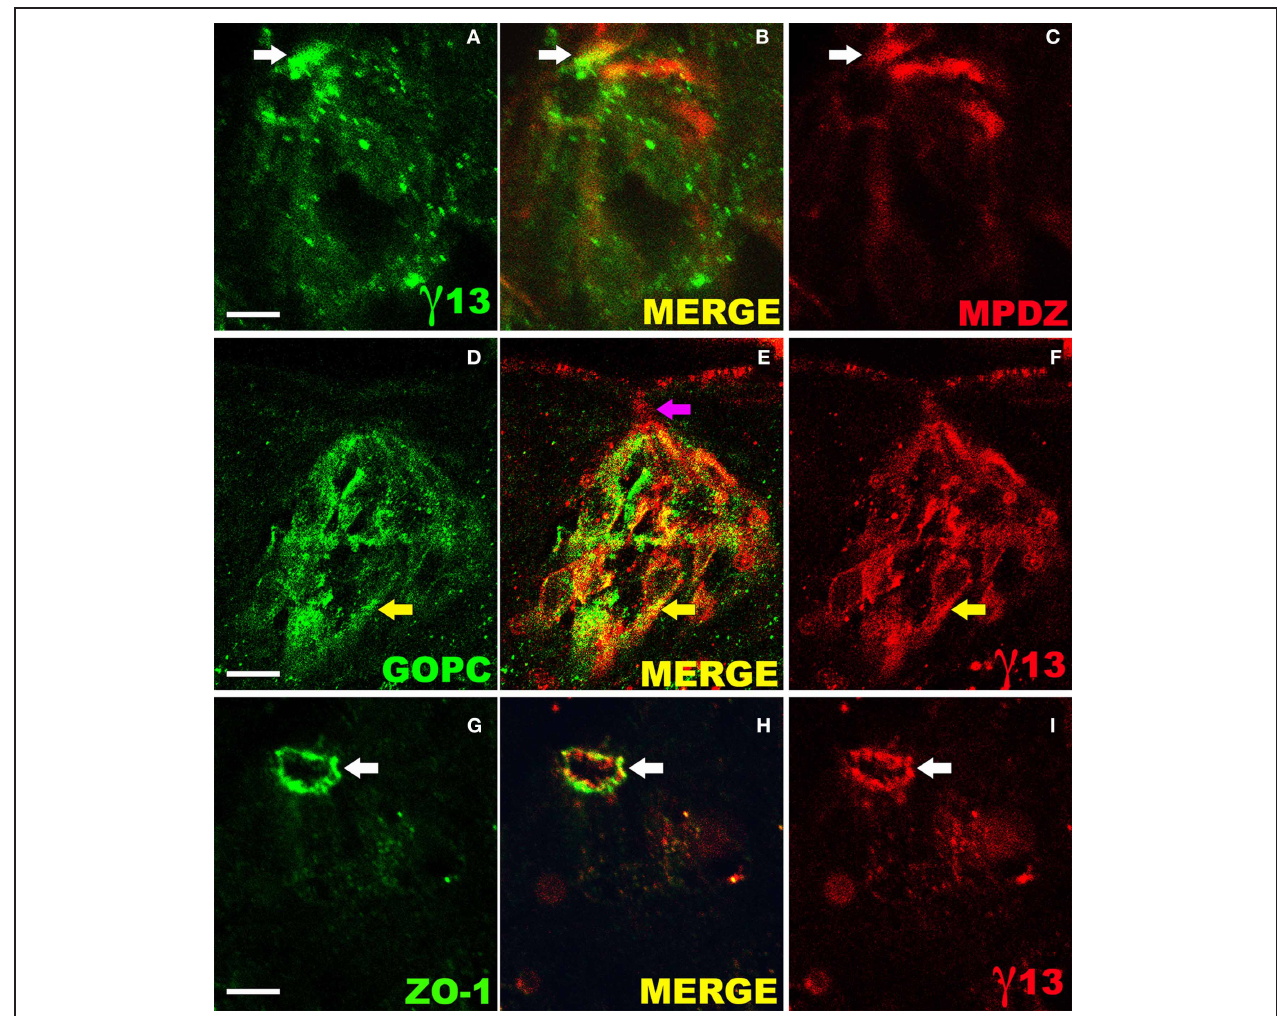
extensive overlap in the cytoplasmic region (yellow arrows) but not near the pore (purple arrow). Partial co-localization of ZO-1 and G γ -13 (G–I) is evident at the pore where tight junctions are located. The images presented are single optical sections (not stacks) collected under strict confocal conditions (airy disk 1, GOPC/G γ -13 Pinhole 82 μ m, GOPC or ZO-1/G γ -13 Pinhole 115 μ m). Confocal images where merged electronically using Photoshop. Scale bar 15 μ m. Images are representative of staining patterns obtained in > 6 taste buds from three